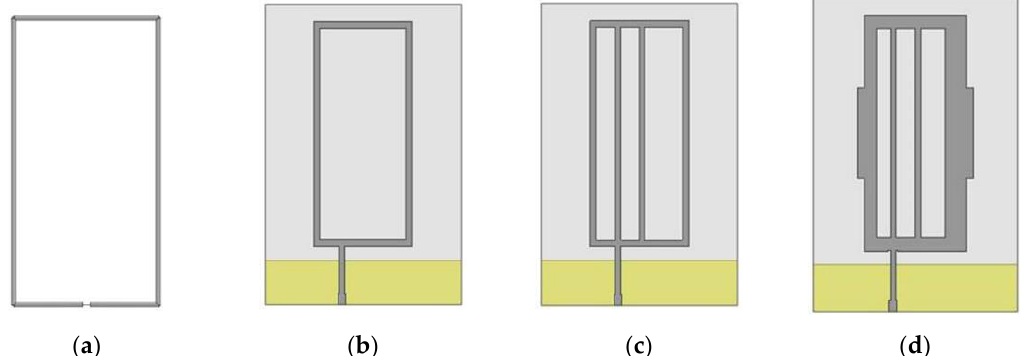
Figure 6. The geometry of loop antennas: ( a ) basic loop antenna; ( b ) modified antenna 1; ( c ) modified antenna 2; and ( d ) final antenna.